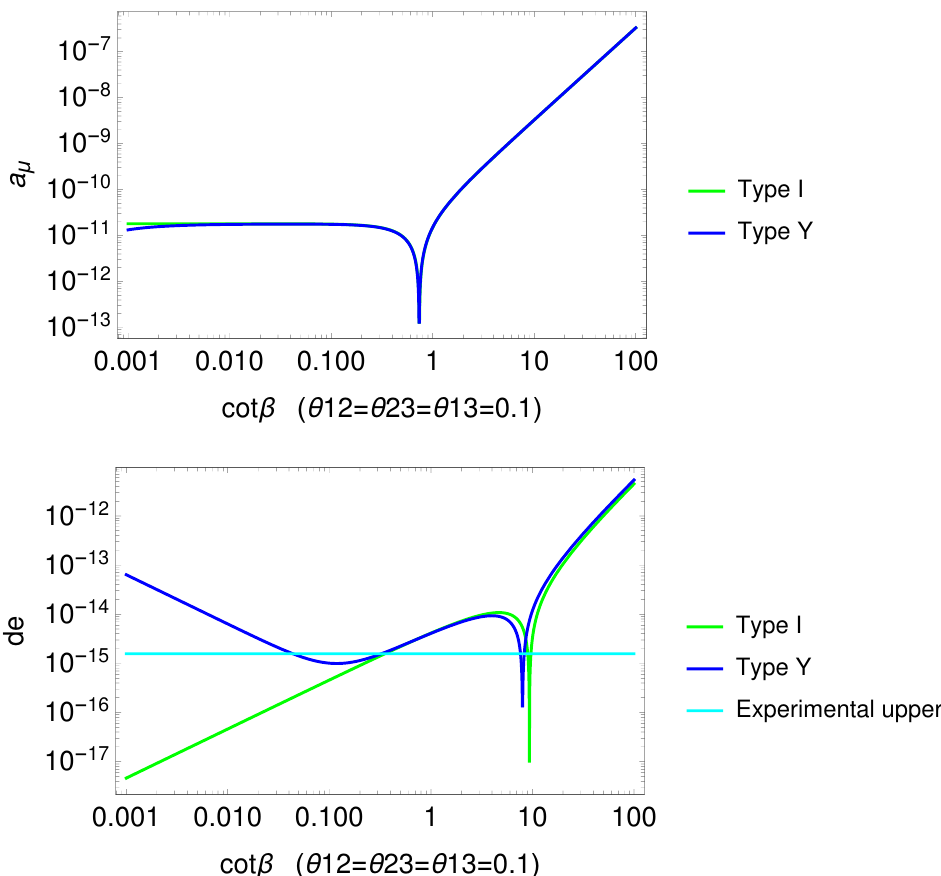
Figure 12 . a (cid:22) (top) and d e (bottom) values in Type I,Y for (cid:12)xed values of angles and masses ( m h = 150 ; 140 2 ; 3